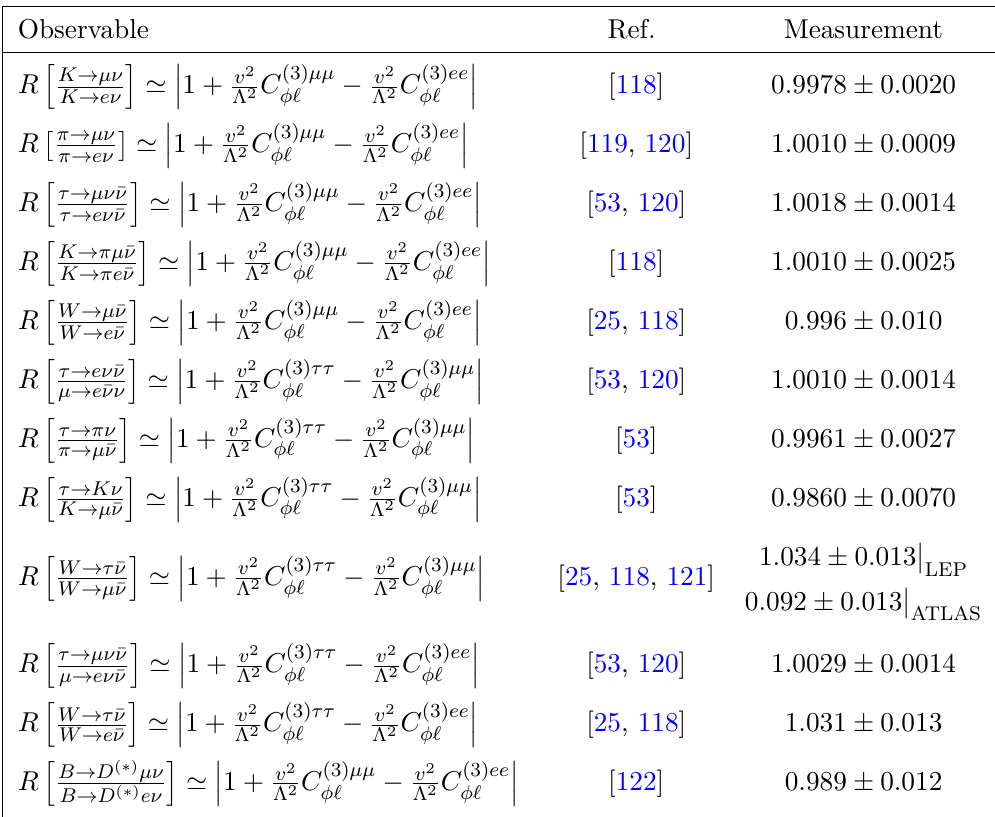
Table 2 . Ratios testing LFU together with their dependence on the Wilson coefficients C (3) ij and the corresponding experimental values. Note that here deviations from unity measures LFU